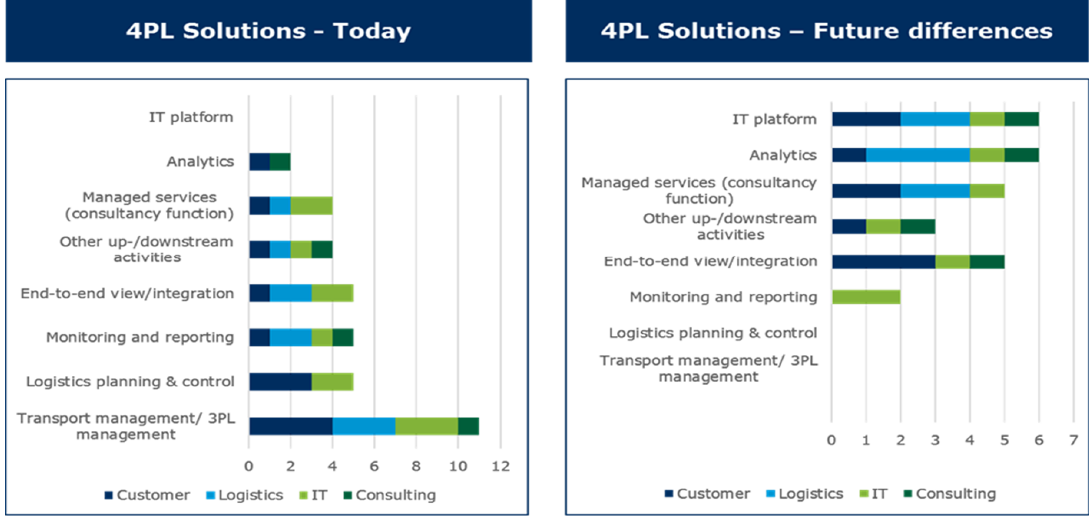
Figure 2. Comparison of 4PL solutions: results from semi-structured interviews.